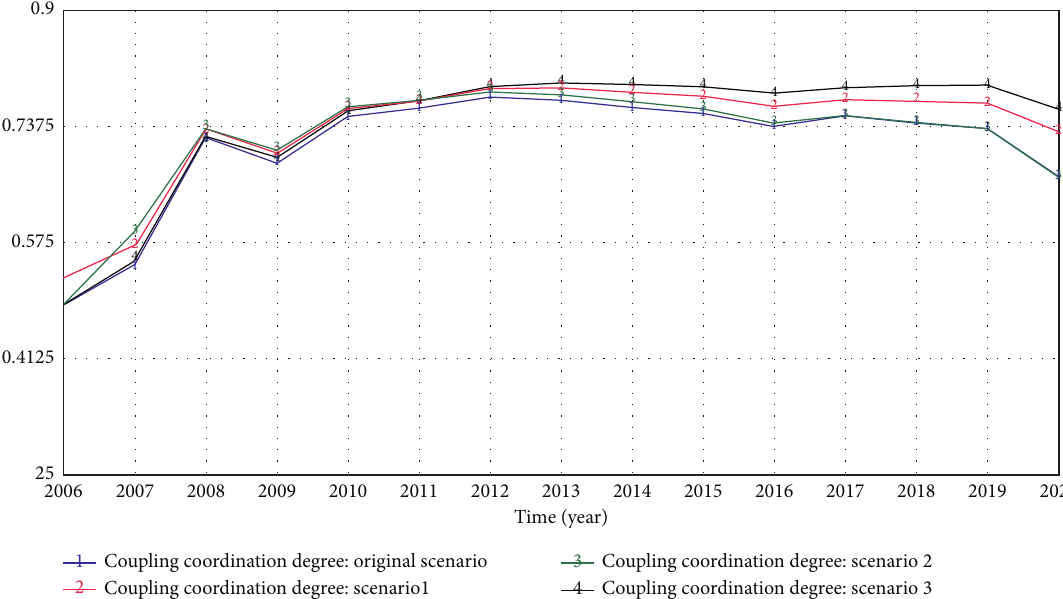
Figure 6: Influence of single factor change on the green low-carbon development level of coal